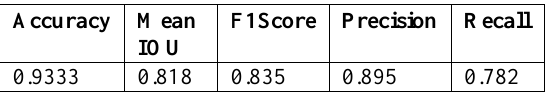
Table 1. Semantic segmentation performance